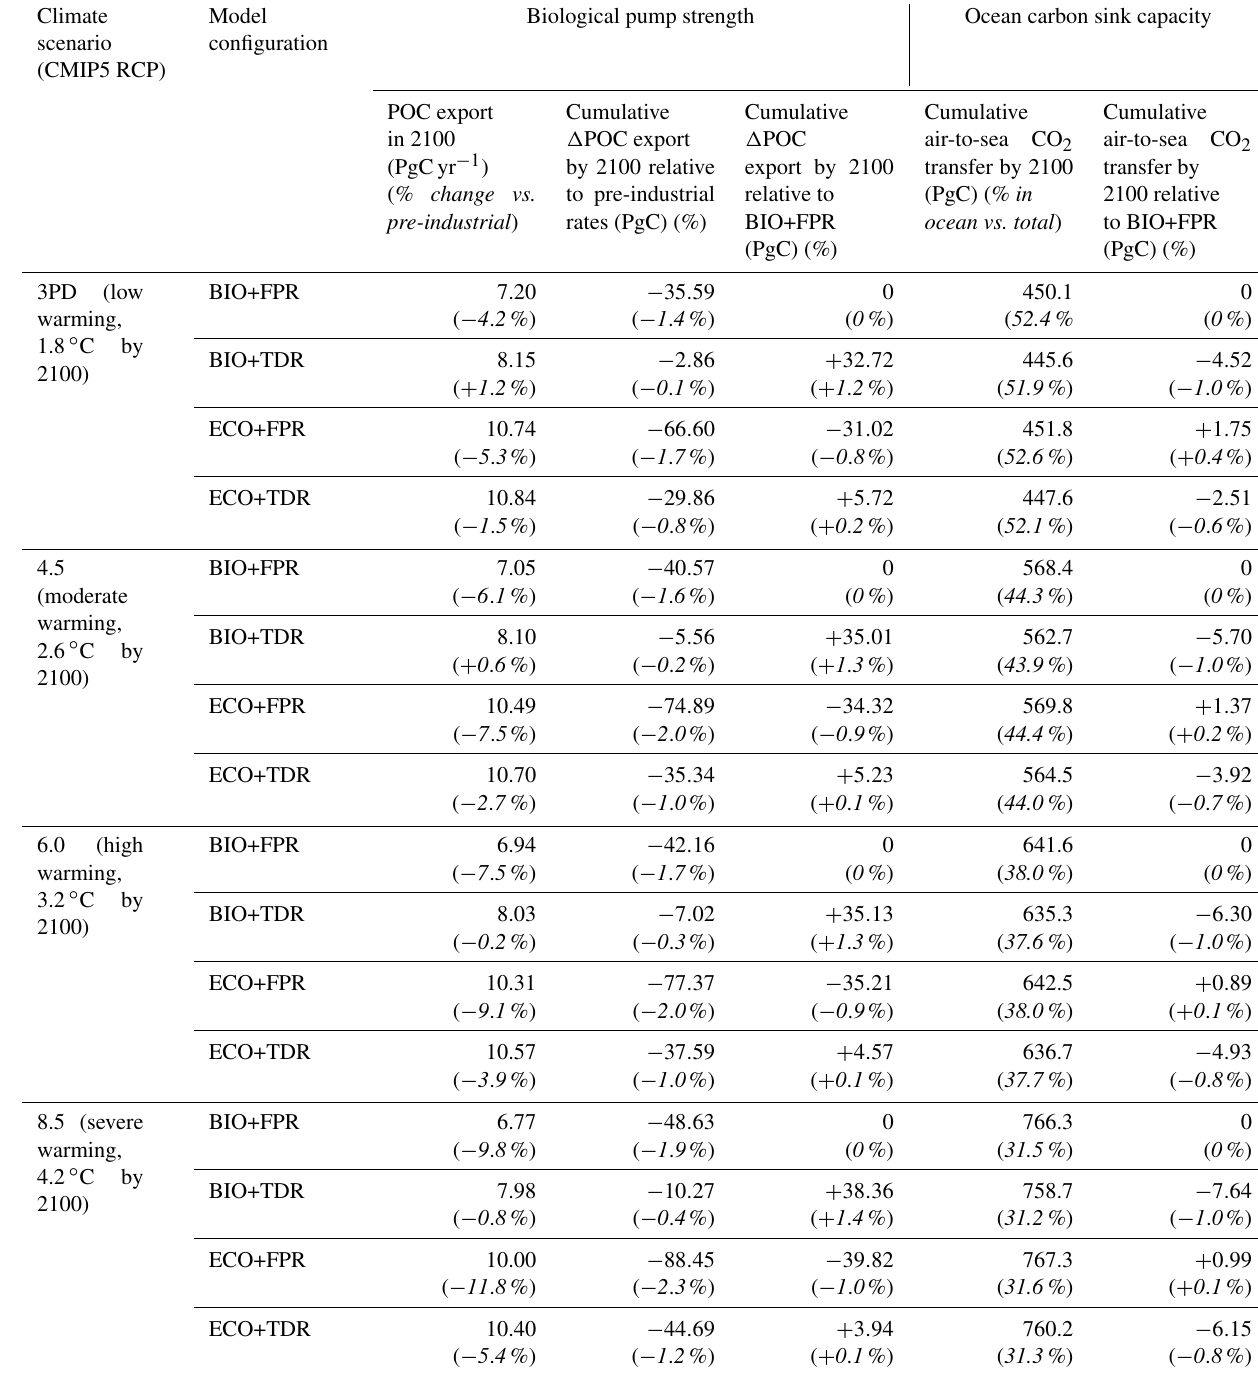
Table 2. Simulated changes in POC export and air-to-sea CO 2 flux by 2100CE under different climate scenarios (CMIP5 RCPs 3PD, 4.5, 6.0, and 8.5), illustrating the relative changes in biological pump strength and ocean carbon sink capacity respectively. Italicised values in parentheses represent the changes as percentages, as described by the parenthesised